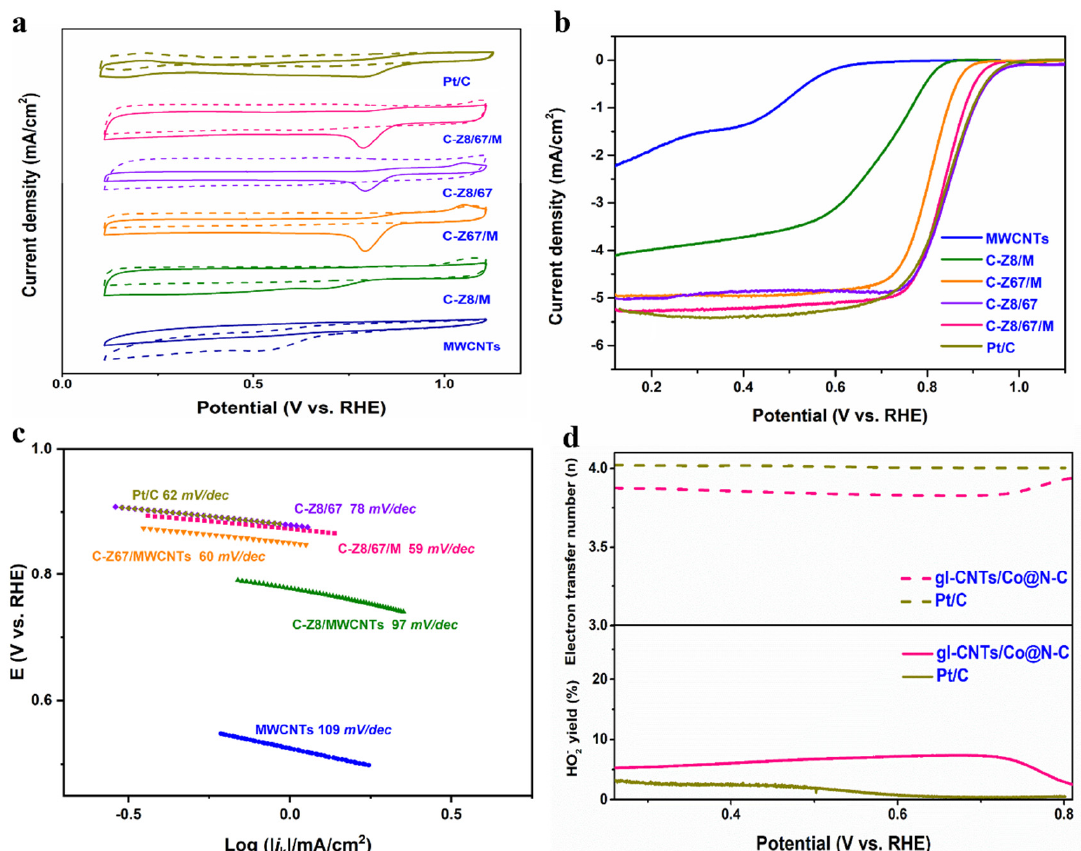
Figure 4. CV ( a ), LSV ( b ), and Tafel ( c ) curves for MWCNTs, C-Z8/M, C-Z67/M, C-Z8/67, gl- CNTs/Co@N-C, and Pt/C; ( d ) Peroxide yields (H 2 O 2 %) and electron transfer numbers (n) of gl-CNTs/Co@N-C and Pt/C. All electrolytes involved have been 0.1 M KOH solution. Meanwhile, the contrast measurements were implemented to evaluate the perfor- mance difference between as-synthesized gl-CNTs/Co@N-C and commercial Pt/C catalyst, including the tiresome methanol crossover and the long-term electrochemical durability. In order to investigate the methanol tolerance, the CV measurements within O 2 -saturated 0.1M KOH solution with or without methanol (0.5 M) were performed. In Figure 5a, the oxygen reduction peak of gl-CNTs/Co@N-C is almost unchanged, indicating that gl-CNTs/Co@N-C possesses good tolerance for methanol crossover. Conversely, according to CV curve of Pt/C (Figure 5b), there is a significant methanol oxidation peak, which further indicated the poor methanol tolerance of Pt/C. Furthermore, methanol tolerance of commercial Pt/C and gl-CNTs/Co@N-C (Figure 5c) was evaluated and compared using the i - t technique. The ORR current density of the gl-CNTs/Co@N-C did not change significantly after injection of methanol for 900 s, indicating that gl-CNTs/Co@N-C had good resistance to methanol cross-effects. In contrast, the ORR current density of com- mercial Pt/C catalysts was significantly reduced due to the inherent vulnerability of Pt electrocatalysts to methanol.